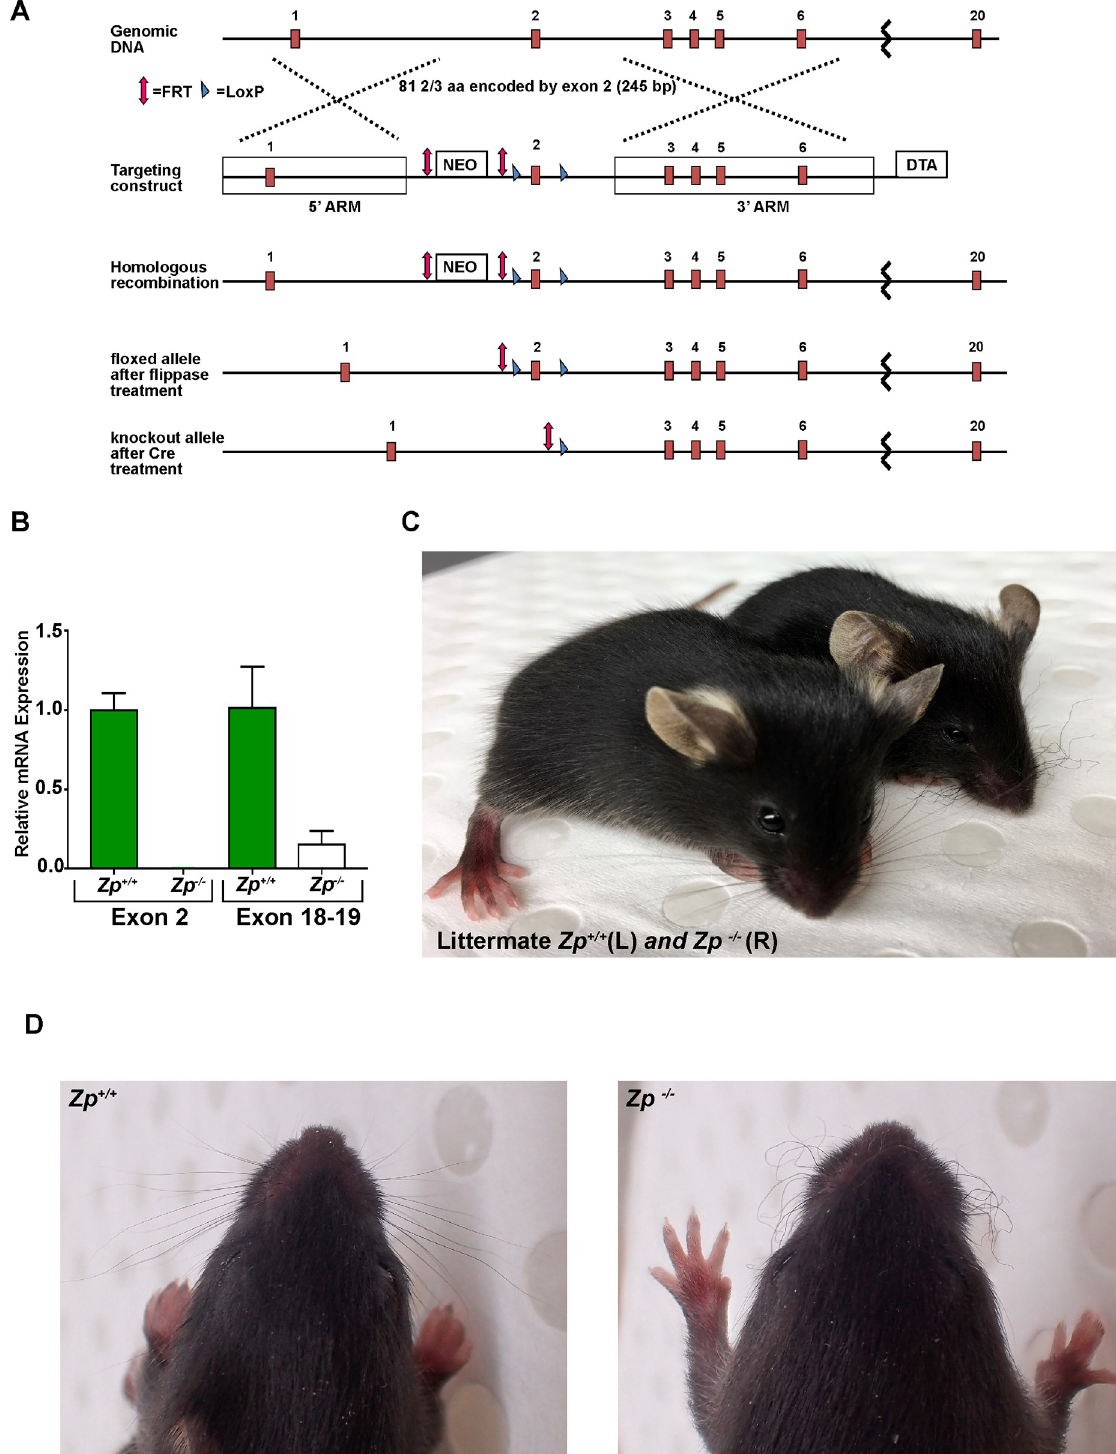
Fig 5. Generation and phenotype of Hephl1 knockout mice. (A) Schematic showing structure of the Hephl1 genomic region and the strategy used to generate the Hephl1 knockout ( Zp -/- ) allele (for details see Materials and Methods). (B) Quantitative real time PCR analysis of Hephl1 mRNA expression in Zp +/+ and Zp -/- placental tissue. No expression was observed in Zp -/- placental tissue using primers specific for exon 2. Expression was significantly reduced in Zp -/- when primers specific for a region downstream of knockout site (exon 18–19) were